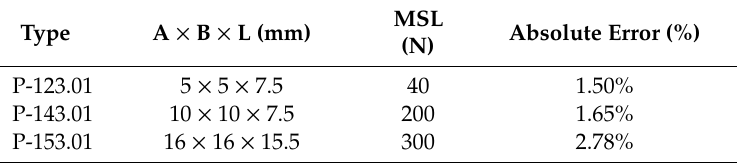
Table 5. Product information and error comparison.